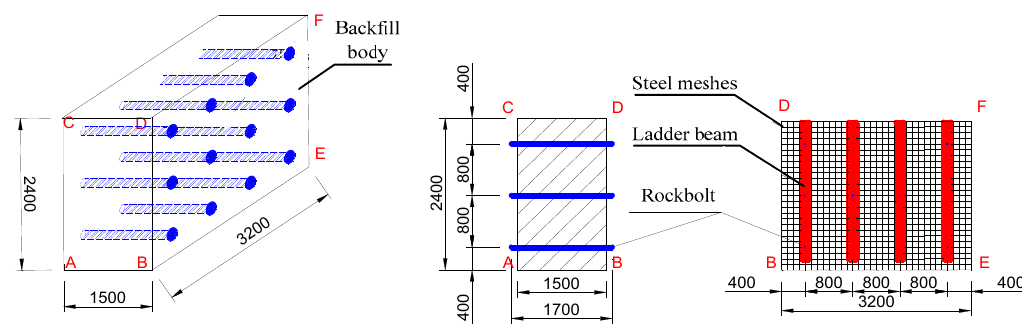
Figure 12. Schematic diagram of reinforcement of backfill body.